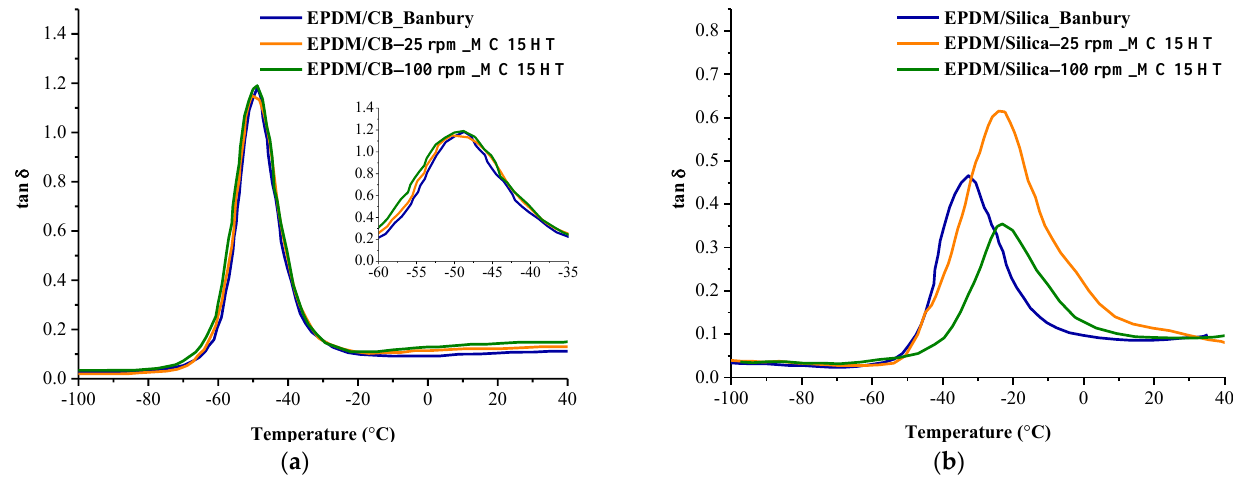
Figure 13. Tan δ of ( a ) EPDM/CB ( b ) EPDM/Silica composites prepared in Banbury and MC 15 HT.